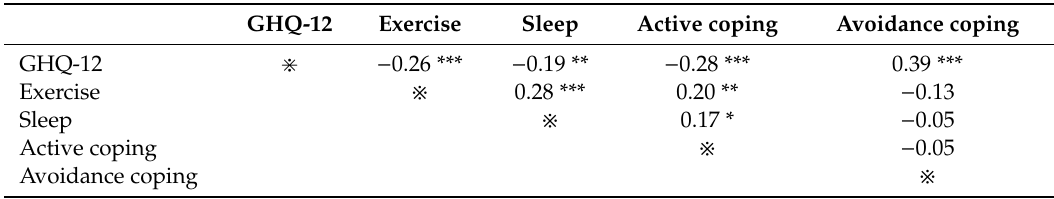
Table 2. Associations between psychological distress, health habits and coping styles (Active coping and Avoidance coping).